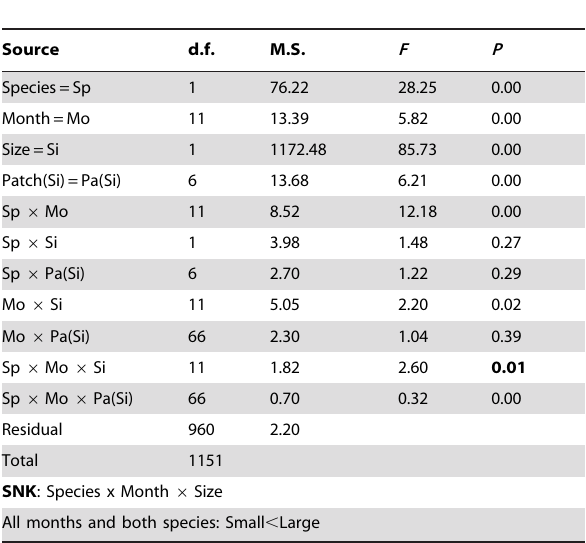
Table 5. Analysis of variance comparing densities of juvenile Siphonaria concinna and S. serrata over 12 months in the Eastern Cape region.